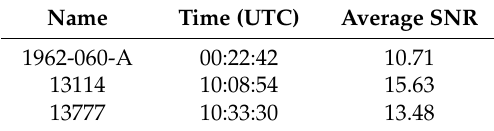
Table 3. Average SNR of the observed target by the K-band photoelectric